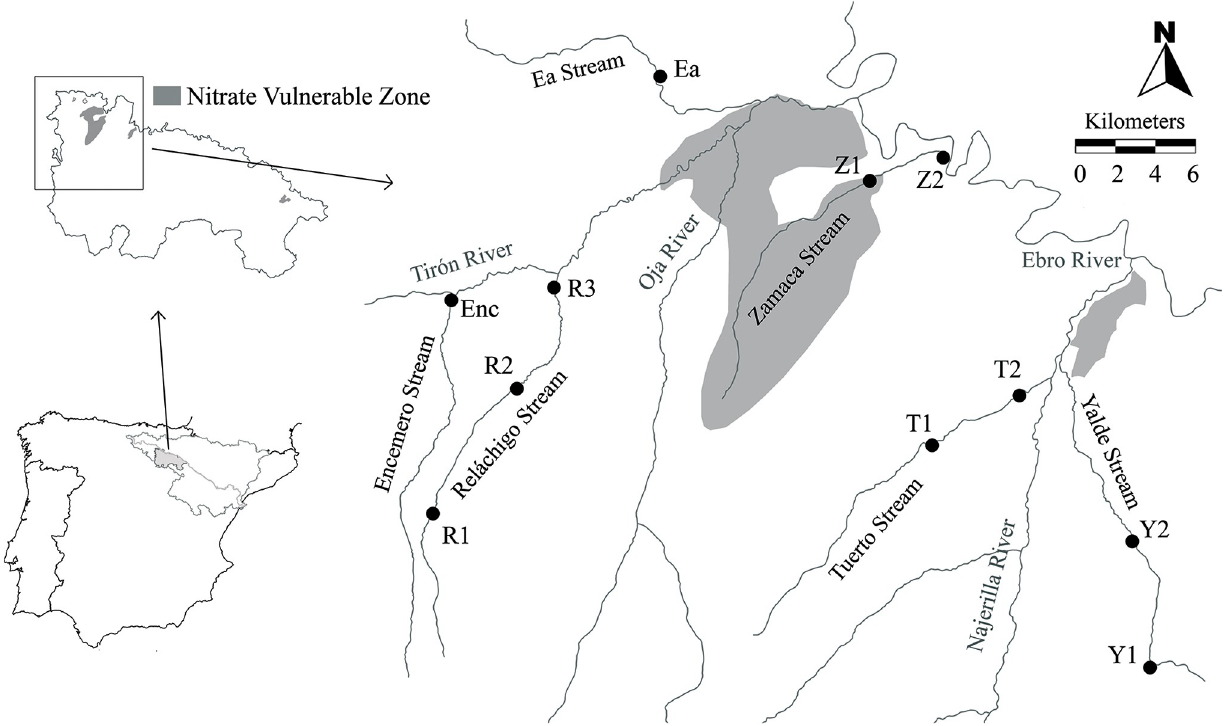
Fig 1. Map of the study area. Sampling sites in the study area (La Rioja, Spain). Nitrate Vulnerable Zones (NVZs) are coloured in grey (“Zamaca and Oja alluvial” and “Low Najerilla alluvial”).